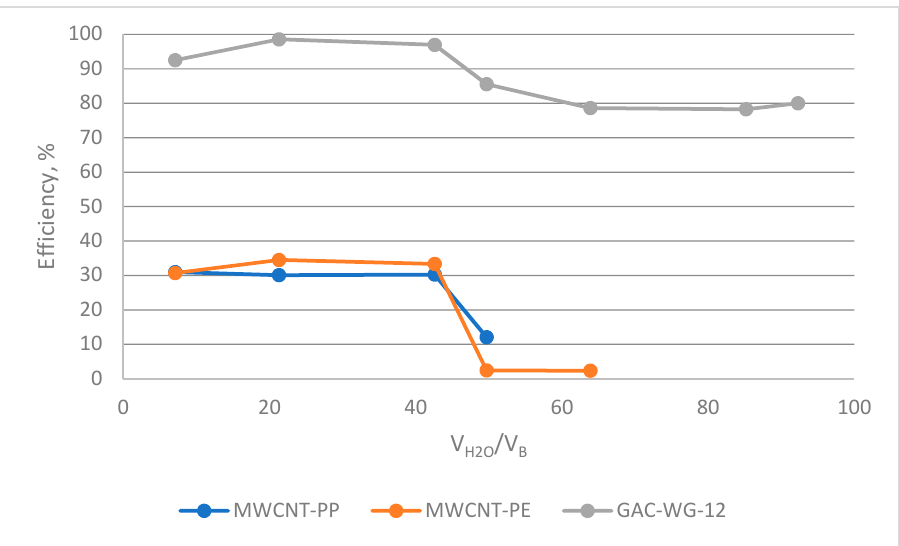
Figure 5. A comparison of the DOC removal effectiveness during the adsorption process.